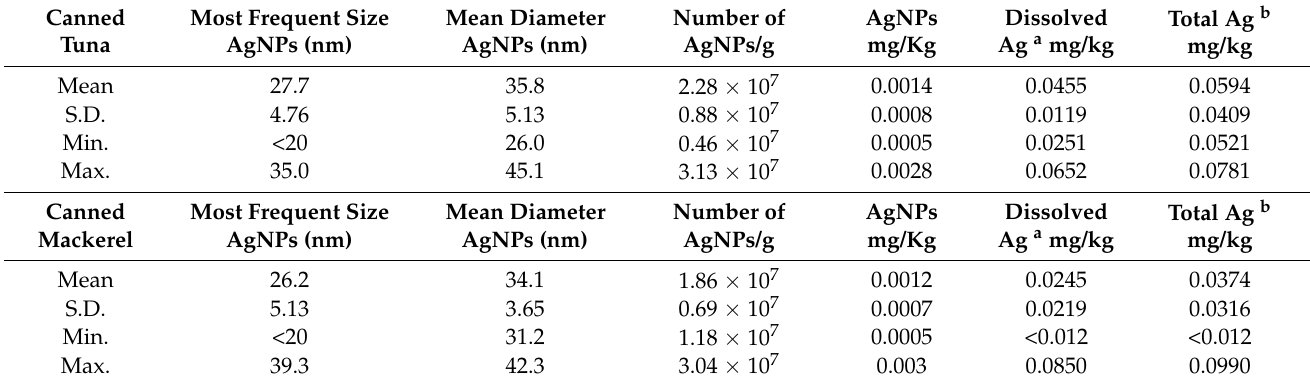
Table 3. Descriptive statistics concerning the chemical characterization and quantification of AgNPs and dissolved Ag (mg/Kg) in packaged seafood